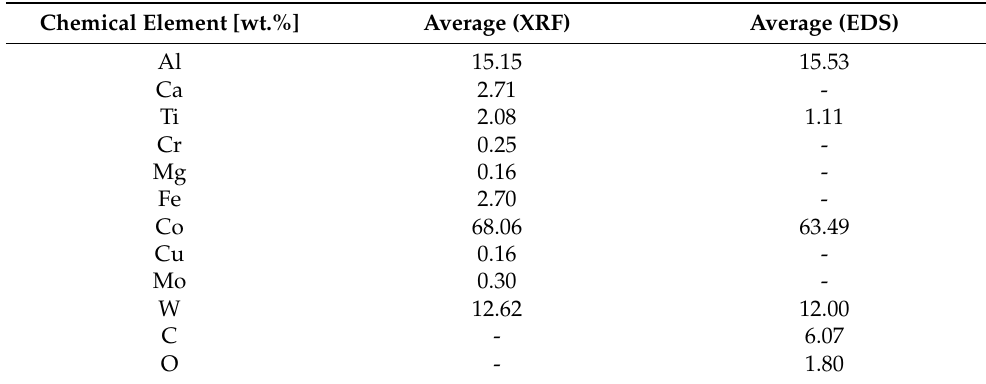
Table 4. Results of the chemical composition of the produced Co70W12Al15 alloy analyzed by X-ray fluorescence spectrometer (XRF) and area EDS analysis. Chemical Element [wt.%]